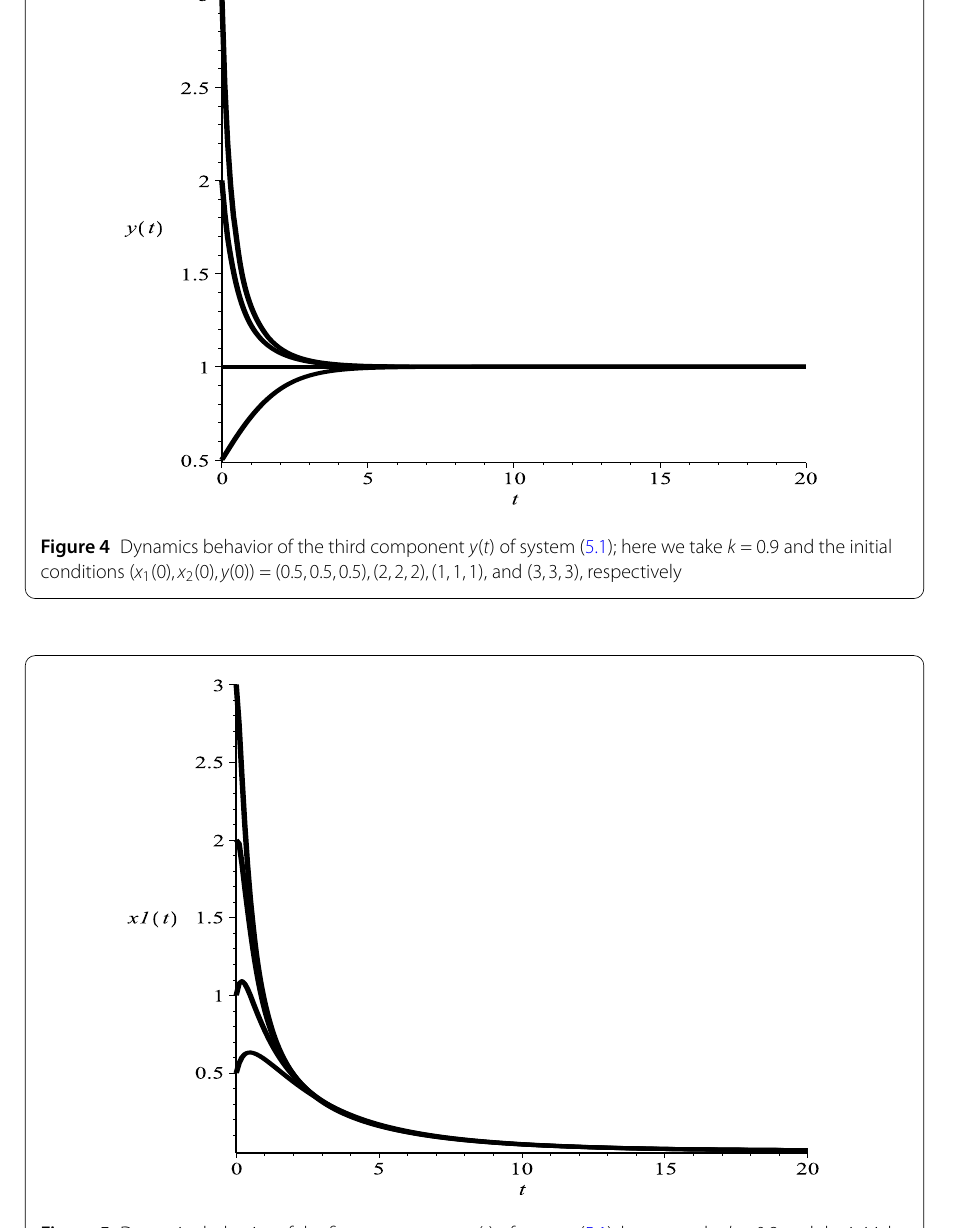
Figure 5 Dynamics behavior of the first component x 1 ( t ) of system (5.1); here we take k = 0.2 and the initial conditions (